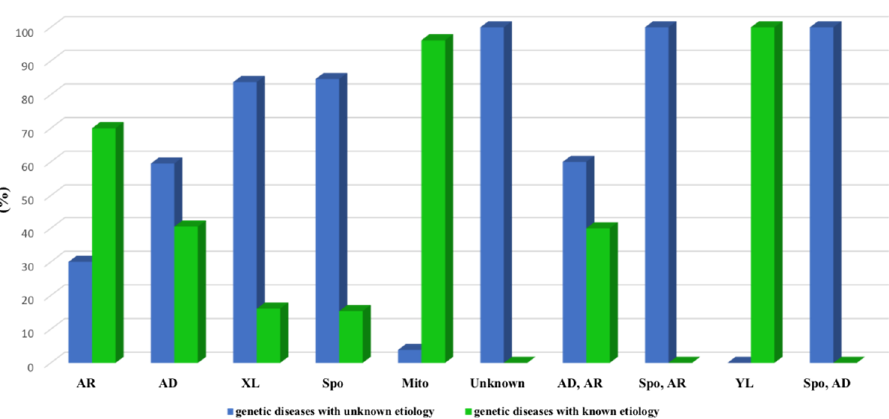
Figure 3. Classification according to the inheritance mode of the whole spectrum of genetic disorders (AR: Autosomal Recessive; AD: Autosomal Dominant; XL: X-linked; Spo: Sporadic; Mito: Mitochondrial; YL: Y-linked).